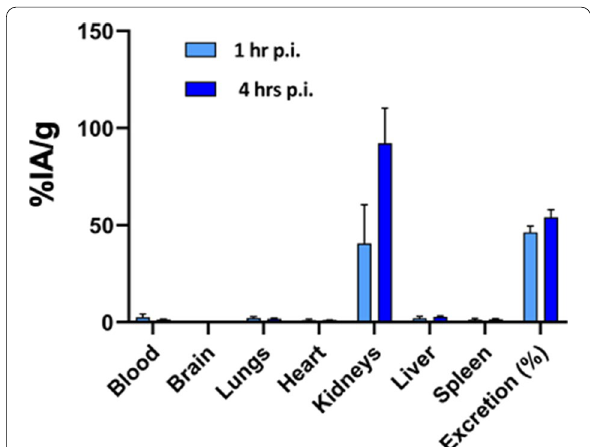
Fig. 5 In vivo biodistribution. Quantitative in vivo biodistribution and excretion of [ 111 In]In-DTPA-P0 101–125 at 1 (light blue) and 4 h (dark blue) post-intravenous tracer administration (tail vein). Uptake per organ presented as percentage of the injected activity per gram of tissue (%IA/g). Excretion was defined as: (MBq present in animal at 24 h post-tracer administration/injected activity) *